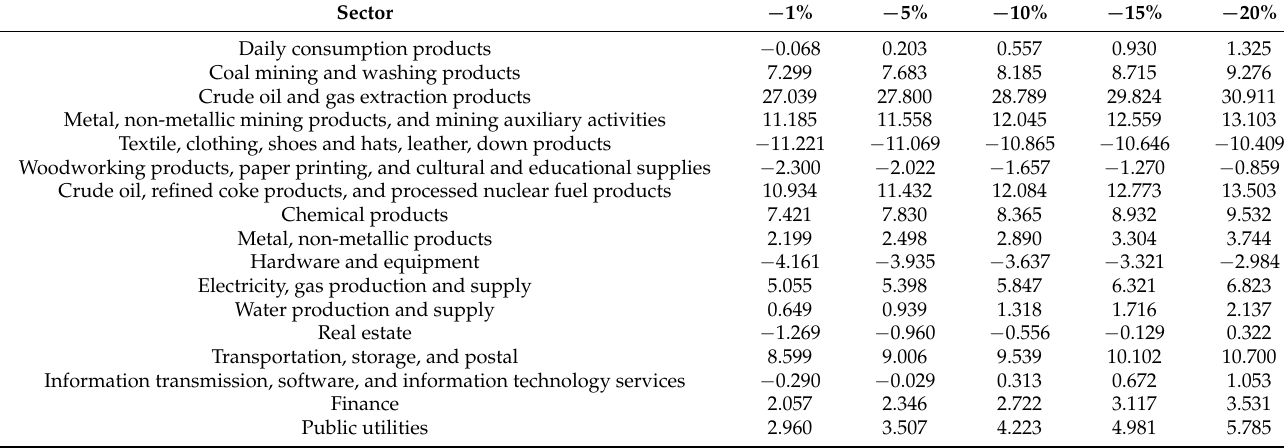
Table A14. The rate of change in output after the decline in crude oil